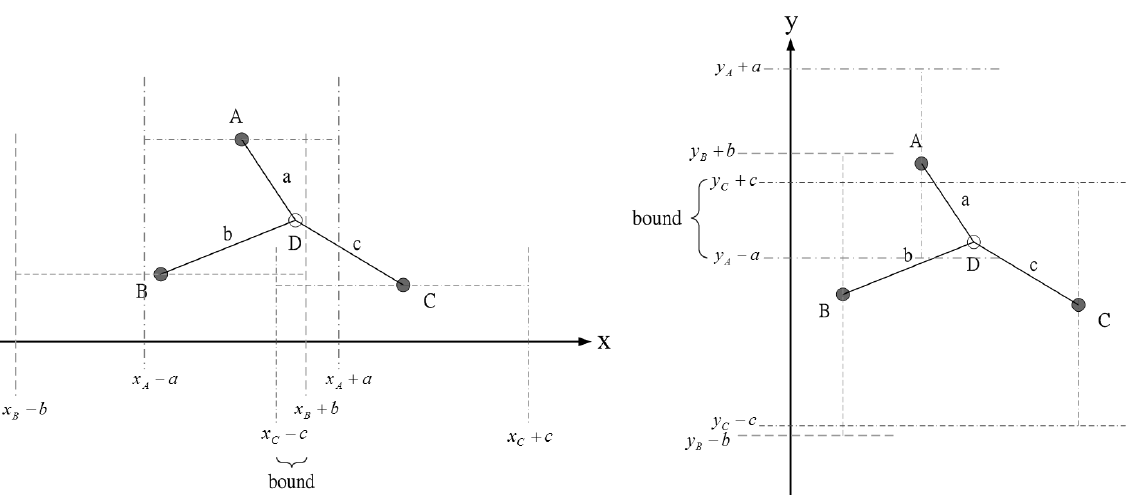
Figure 3. An example of obtaining the x and y coordinate bounds of the unknown sensor D by the distance and position information of the known sensors A, B, and C.